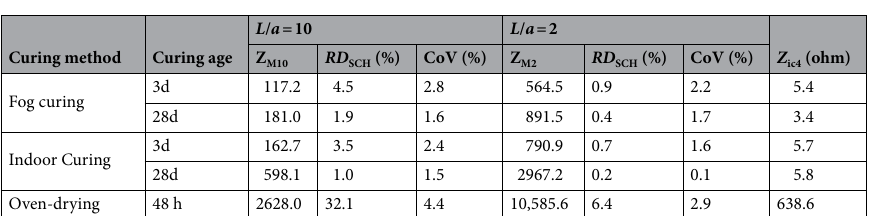
Table 4. Contact impedance values measured by four-point measurement. CoV means variation coefficient of test results of three samples. RD SCH means relative deviation of contact impedance using SCH as a conductive media for pure sample impedance. Z M10 and Z M2 mean the total four-point measurement impedance when L / a = 10 and 2,